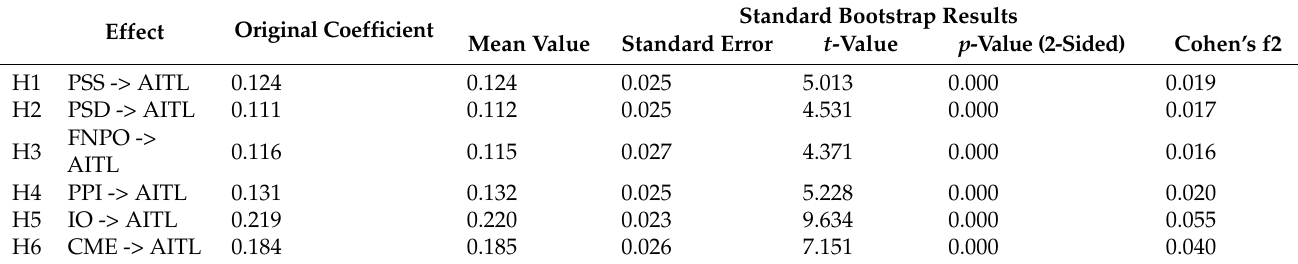
Table A7. Structured path analysis of the proposed model.